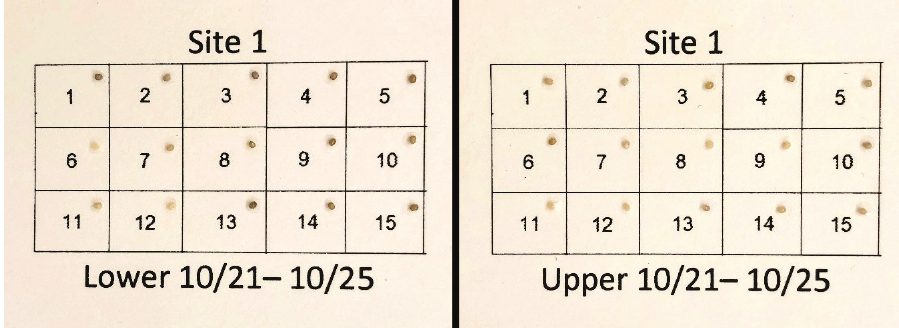
Figure 2. The sentinel card grids with fresh Bagrada hilaris eggs.